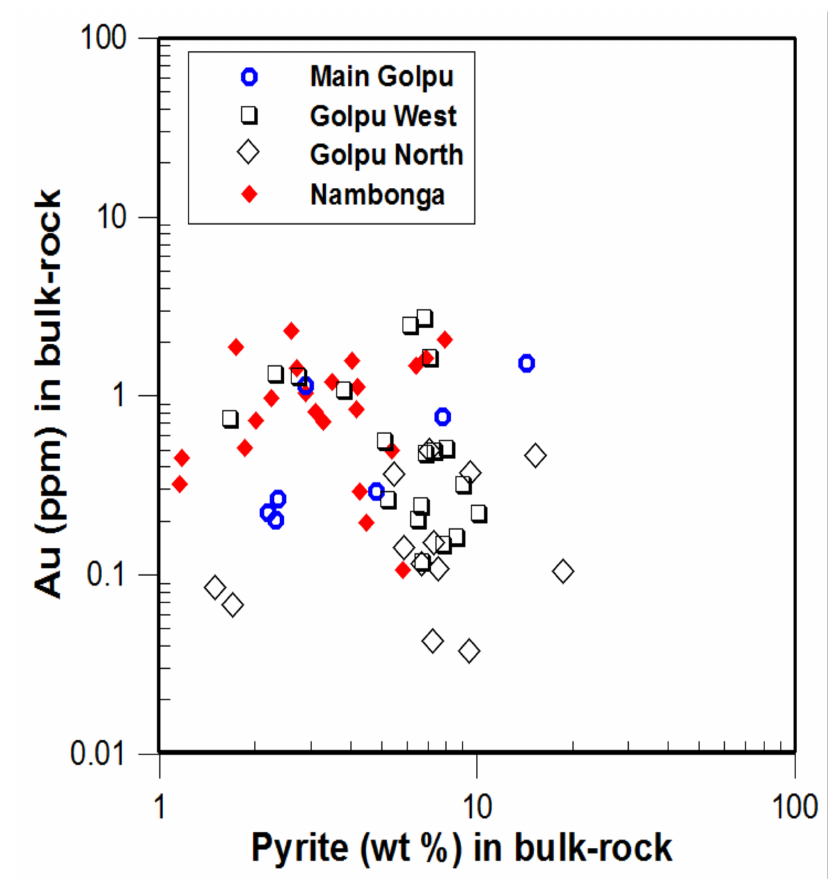
Figure 12. Log-plot of pyrite versus Au in the bulk-rock sample from the Main Golpu, Golpu West, Golpu North and Nambonga North